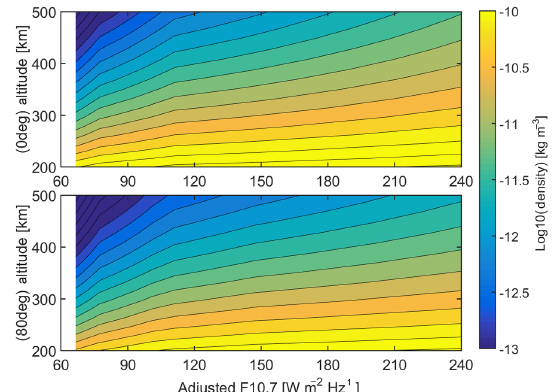
Figure 7. Logarithmic variation in the atmosphere density at 0 ◦ and 80 ◦ N latitude and 14:00LT as a function of altitude and adjusted solar flux (F10.7).